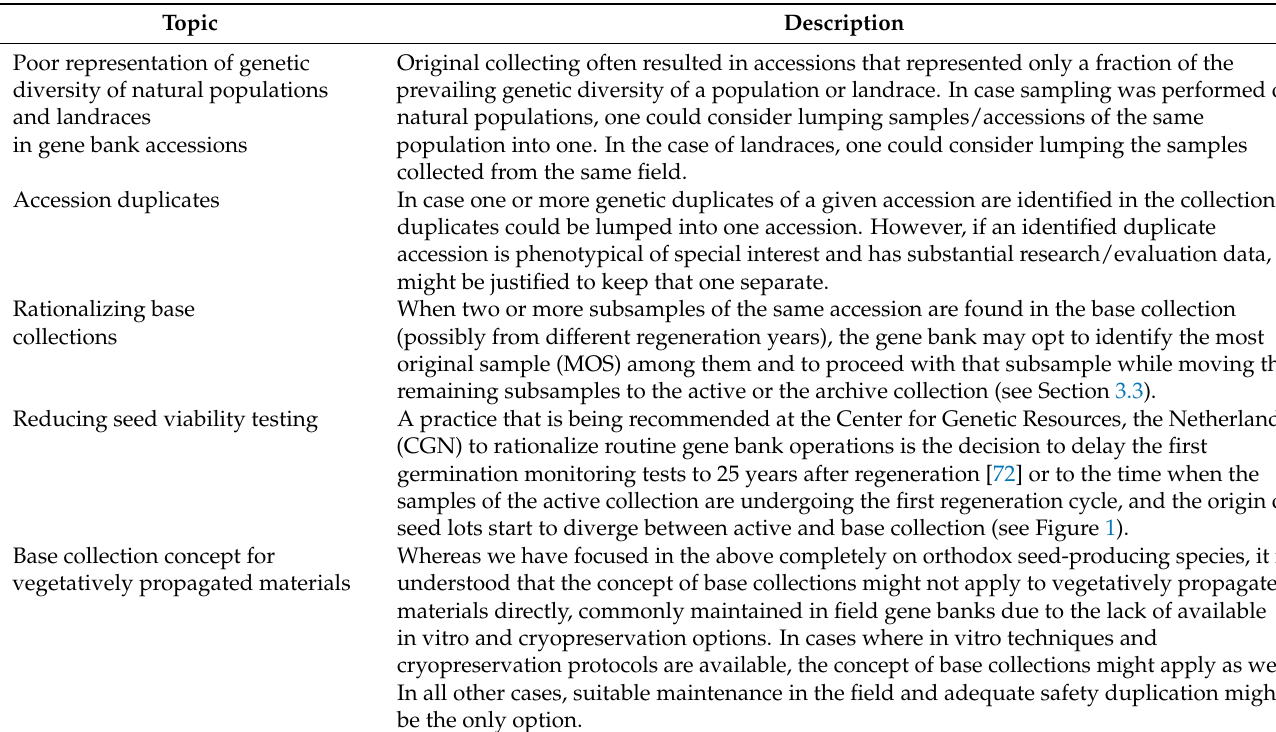
Table 3. Weaknesses of existing base collections and options to overcome those weaknesses to arrive at a more secure and rational long-term conservation system of